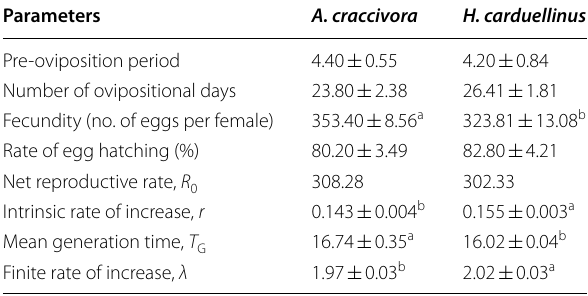
Means followed by same letter do not differ significantly from each other